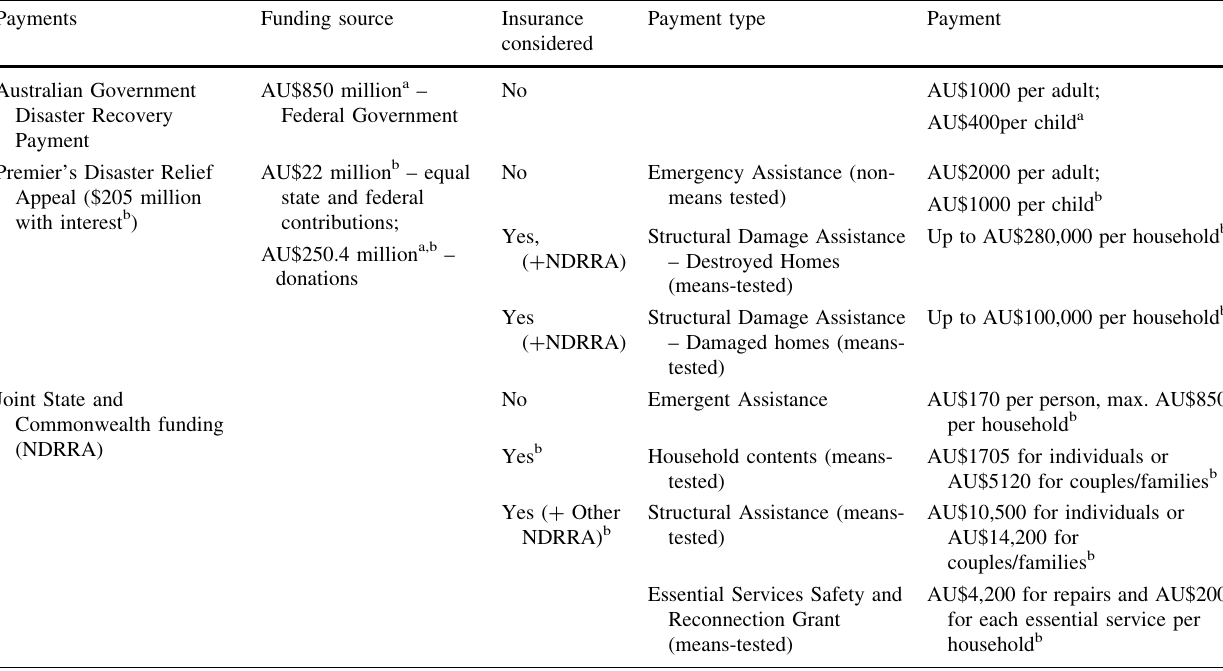
Table 3 Post-disaster impacted household funding, 2010–2011 Queensland floods and Cyclone